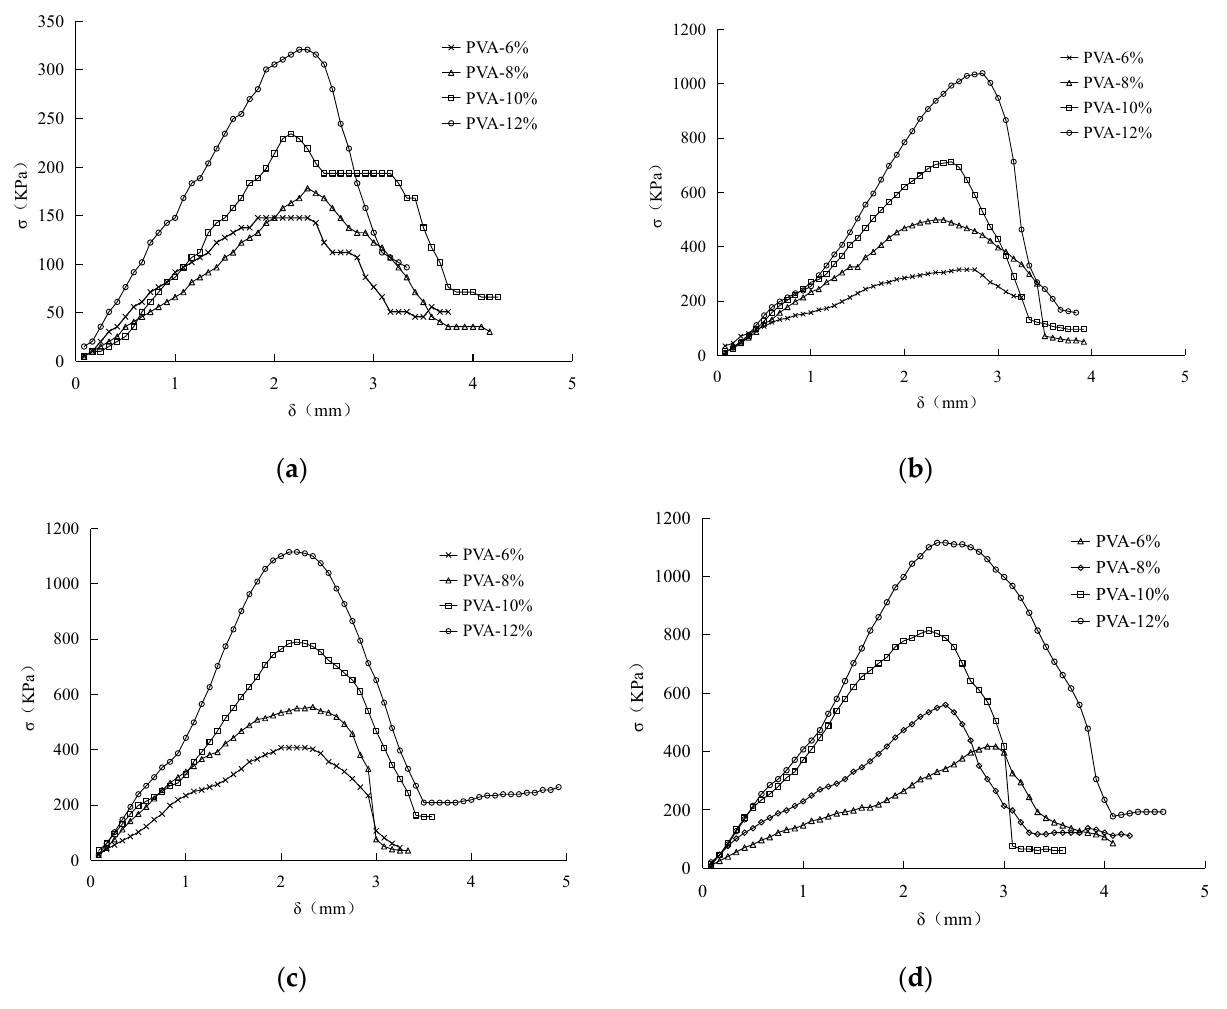
Figure 3. ( a ) 3 day; ( b ) 7 day; ( c ) 14 day; ( d ) 14 day. Stress–strain curves of PVA-improved soil under different curing time.